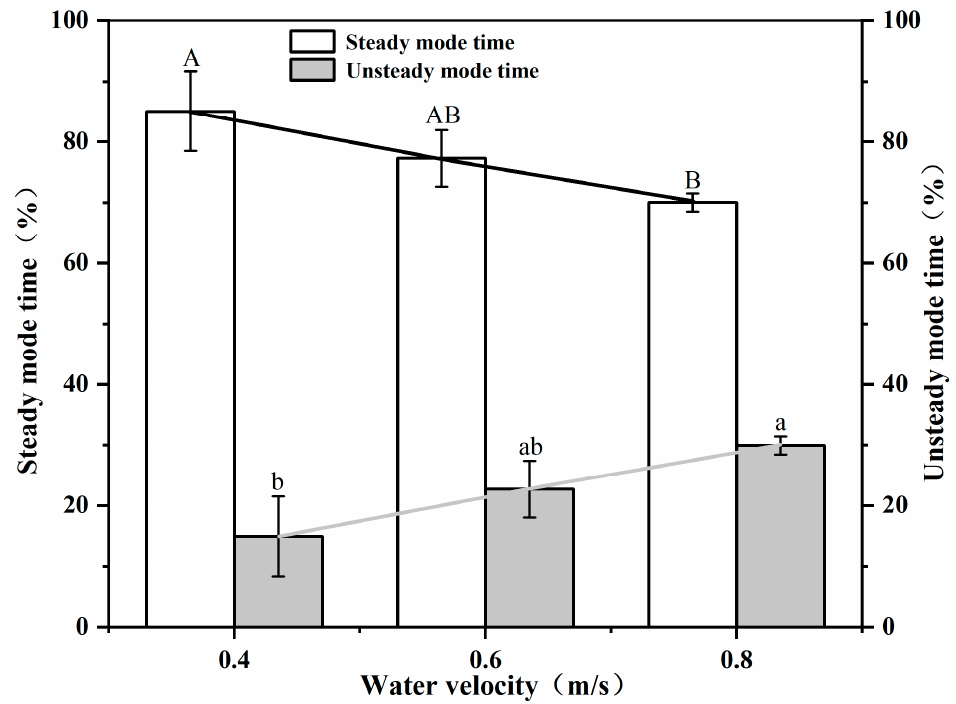
Figure 3. Correlation between steady/unsteady mode time and water flow velocity for S. malacanthus. Different upper cases indicate the significant the difference of water velocity in steady mode time treatments; Different lower cases indicate the significant the difference of water velocity in unsteady mode time treatments.